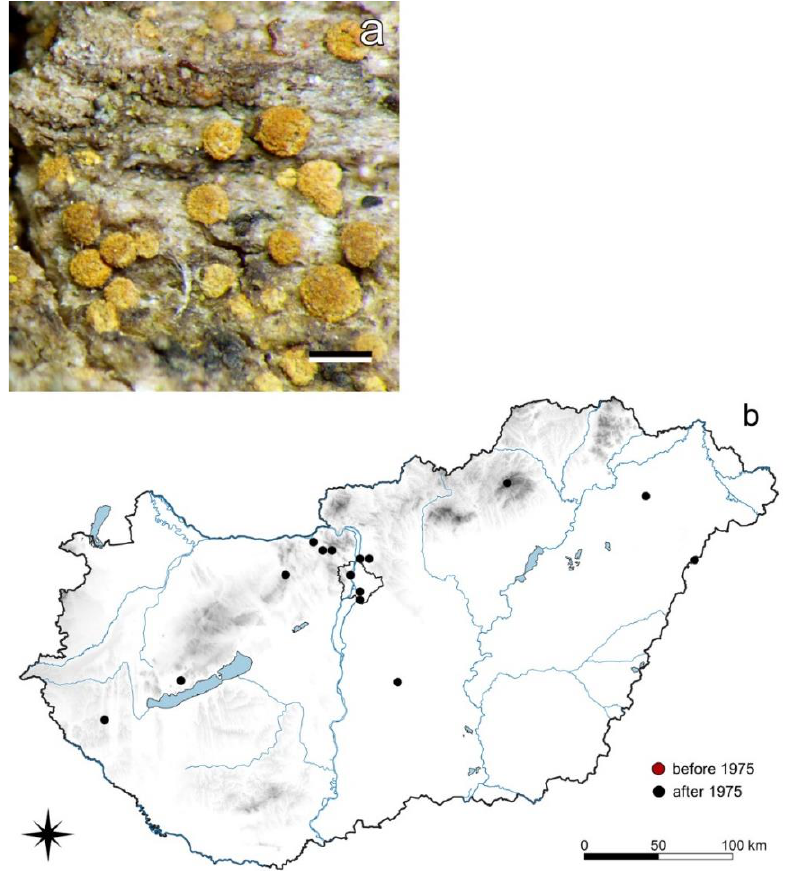
Figure 4. Piccolia ochrophora ( a ) habit (scale 0.5 mm); ( b ) its distribution in Hungary (16 records). Dots represent c. 5 km × 6 km areas. (Photo: E. Farkas).